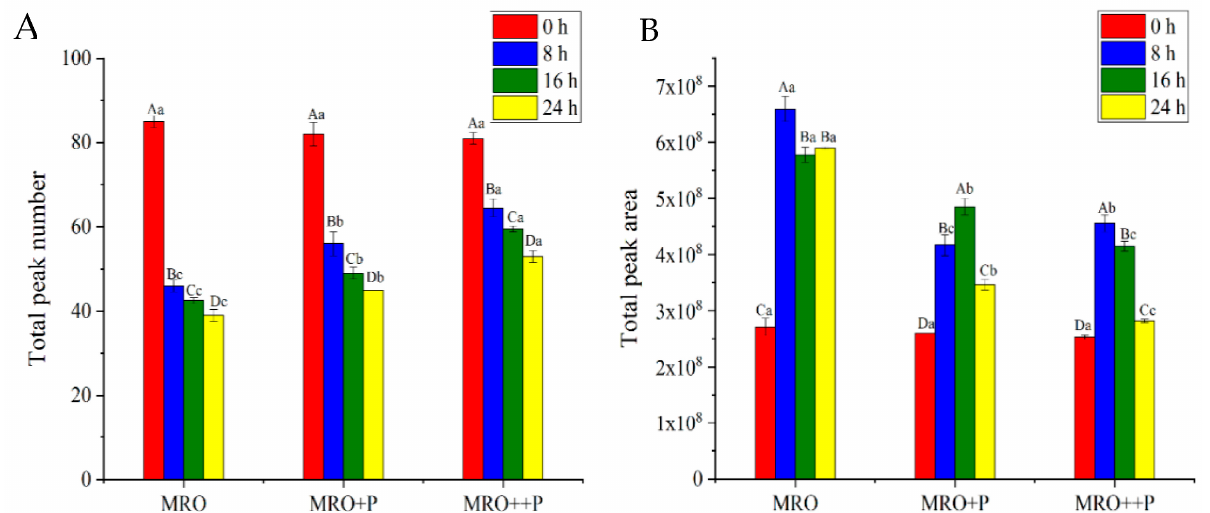
Figure 3. Changes of the total peak number ( A ) and area ( B ) of oil during frying process. Note: Different letters (A–D) indicate significant differences between times for the same oil samples ( p < 0.05); Different letters (a–c) indicate significant differences between oil samples for the same step of